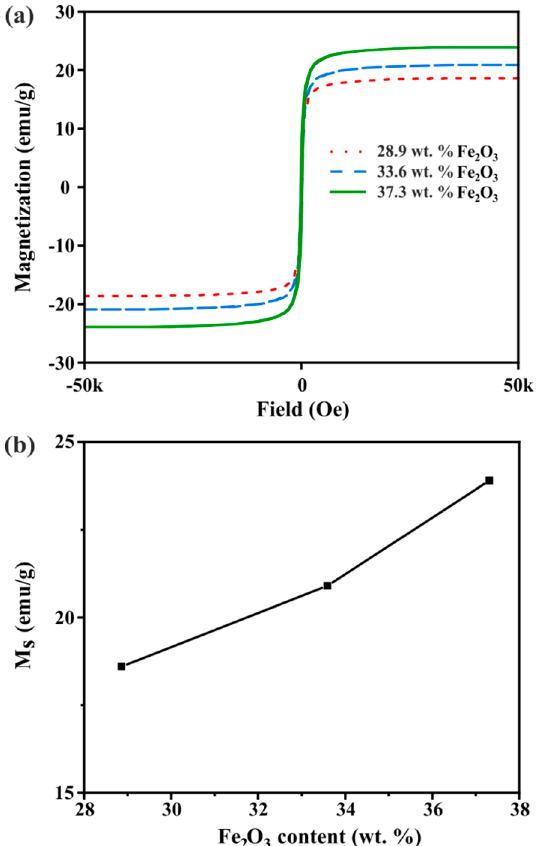
Figure 4. ( a ) SPION-RGO hysteresis loops (magnetization versus field) at 10 K and ( b ) saturation magnetization (M s ) of the hybrids with respect to the loading of iron oxide NPs.